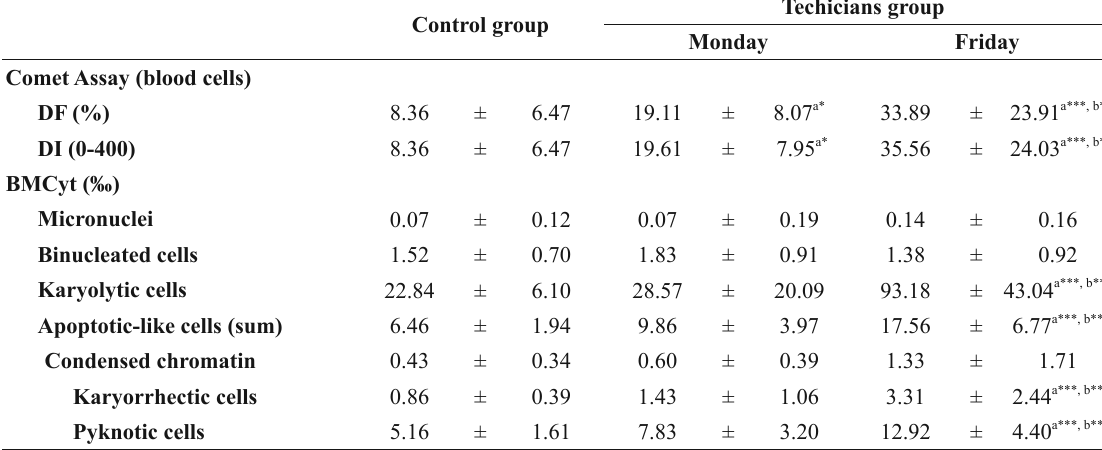
Comet Assay and Buccal Micronucleus Cytome assay results.